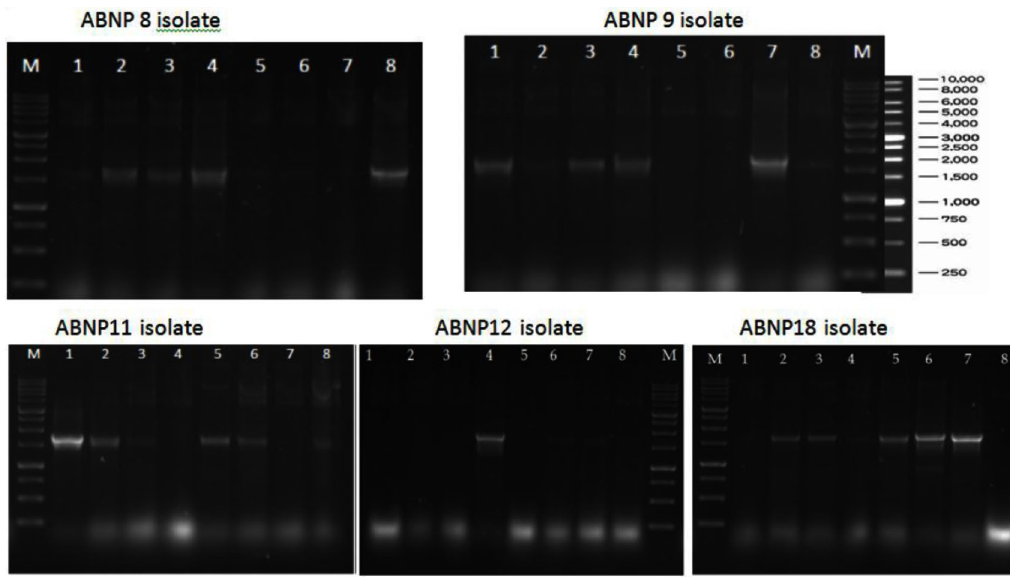
Fig. 2. PCR results from recombinant plasmid PCR colonies Note: M: 1Kb DNA ladder markers, 1-8: eight colonies in each ABNP 8, ABNP 9, ABNP 11, ABNP 12, ABNP 18